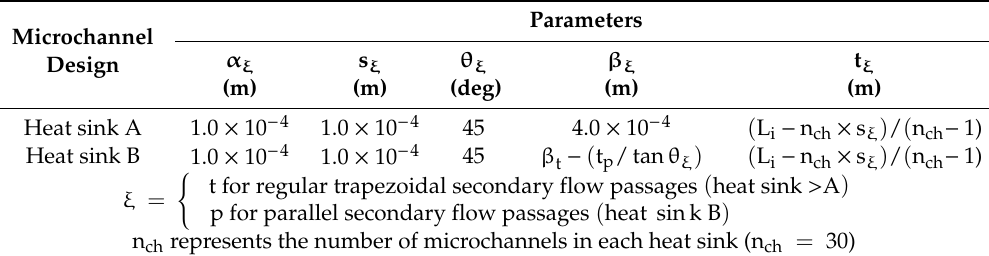
Table 2. Geometric configuration of the microchannels.